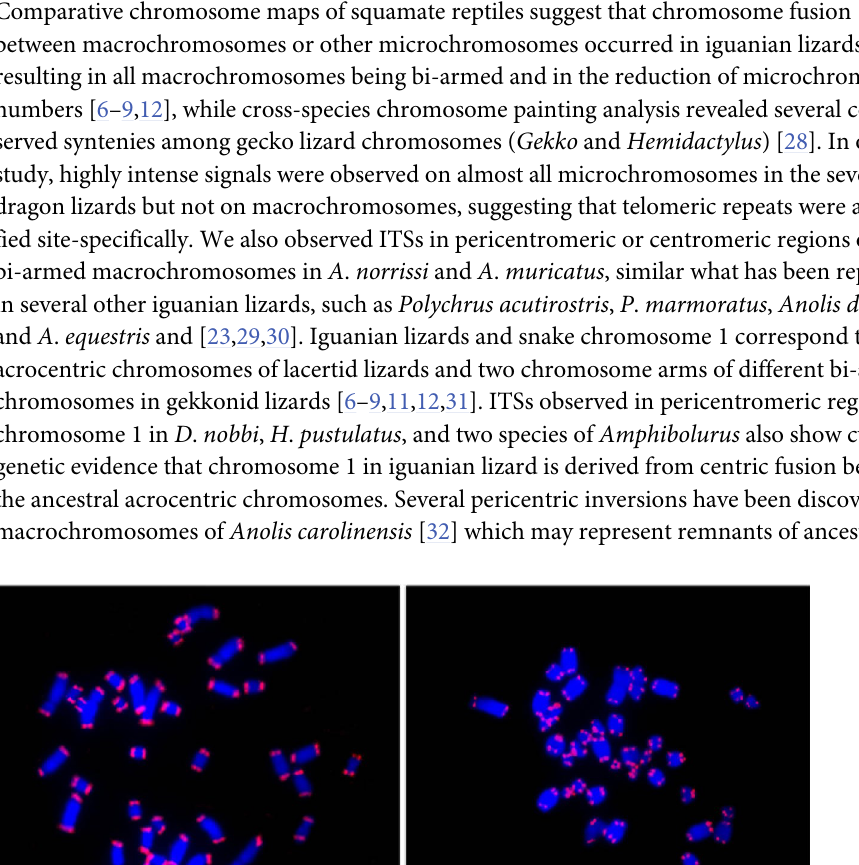
(Table 1). ITSs were localised to the W microchromosome and pericentromeric regions of chromosome 1 in Diporiphora nobbi but only near the pericentromeric region of chromosome 1 in Hydrosaurus pustulatus . By contrast, ITSs were detected in the centromeric regions of all macrochromosomes and two microchromosome pairs in Amphibolurus norrissi and A . muri- catus (Fig 2). No ITSs were found on the gecko lizard H . frenatus (Fig 3).